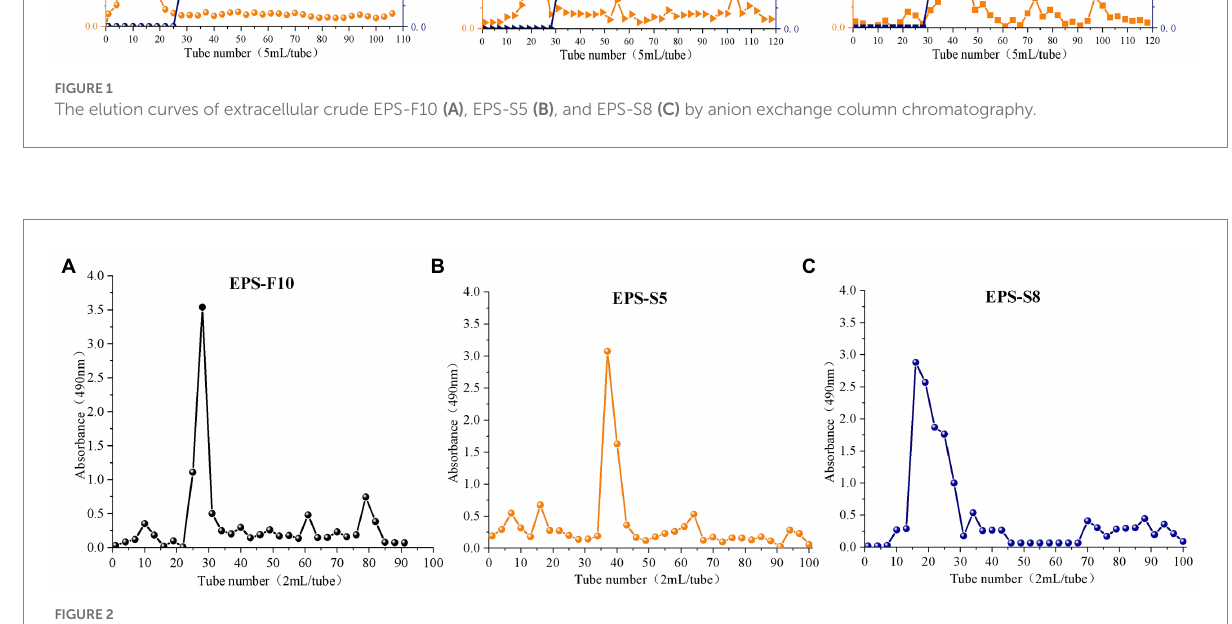
FIGURE 2 The elution curves of EPS-F10 (A) , EPS-S5 (B) , and EPS-S8 (C) by gel permeation chromatography